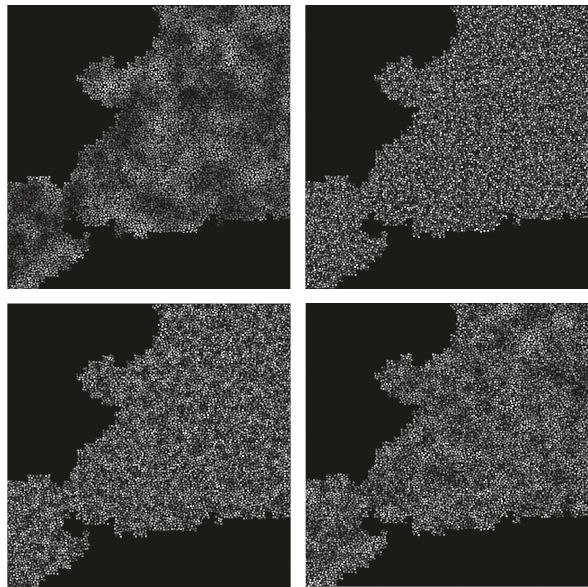
Figure 7: Fractal map for each of four plant species where each point has received fractal values for each plant species based on their patchiness data. Clearly, different kinds of patterns can be identified among the plant species.